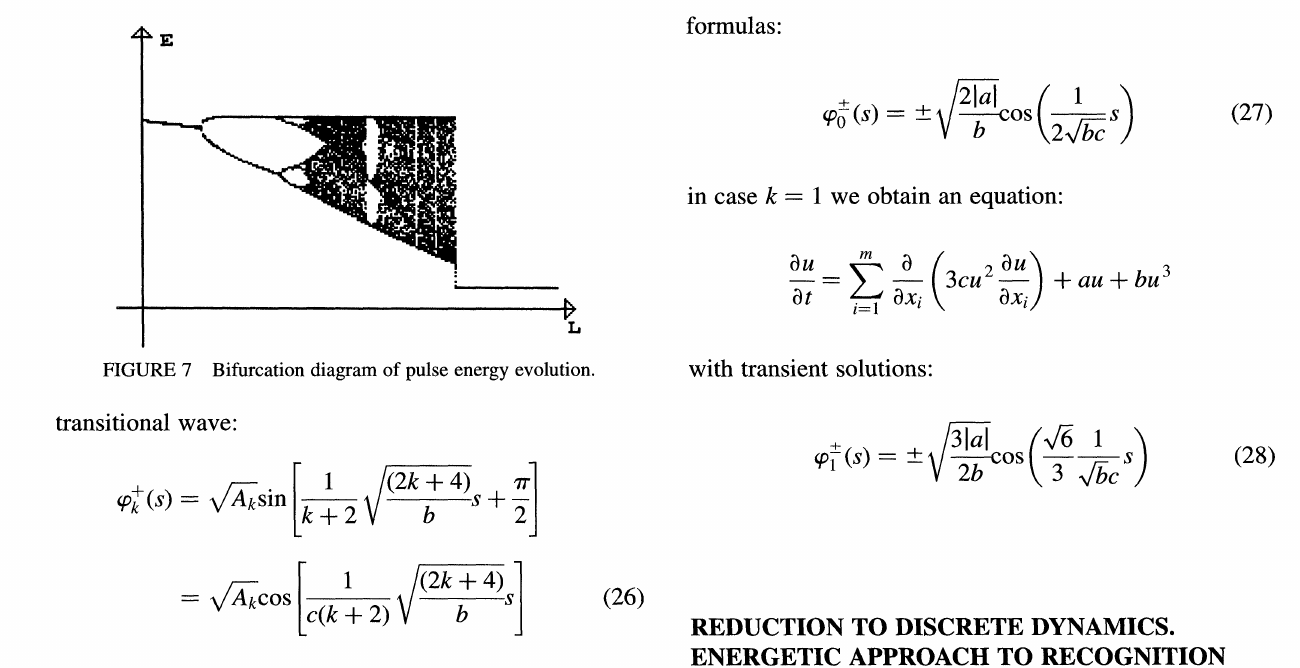
FIGURE 7 Bifurcation diagram of pulse energy evolution.